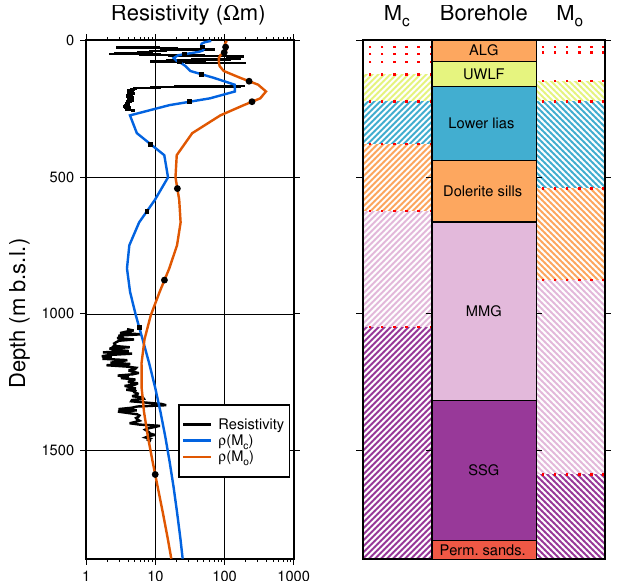
Figure 17. Left-hand panel shows the resistivity columns from both M c (blue) and M o (orange) adjacent to the Port More 1 borehole, plotted with the observed normal resistivity data. Due to the regu- larisation in the inversion process, neither model can reproduce the high variability of resistivities within the ALG observed in the up- permost 100m of normal resistivity data. Note that the resistivity column of M c approaches the observed low resistivities of the LLG and reproduces the trend observed in the MMG and SSG resistivi- ties, albeit with resistivities approximately half a decade greater. In contrast, the resistivity column of M o correlates poorly with the ob- served normal resistivity data, with overestimated resistivities and layer thicknesses. Right-hand panel shows interpreted structure of each resistivity column (patterned, on either side), with the observed borehole lithology in the centre column. The interpreted M c struc- ture shows significantly improved correlation with the observed lithology; in particular, the upper boundary of the MMG against the dolerite sills is recovered much closer to the true depth in M c than in M o . The static-shift correction factors δ E and δ E applied at this x y site were 0.40 and 0.38 ( − 0.40 and − 0.42 in decades) respectively.